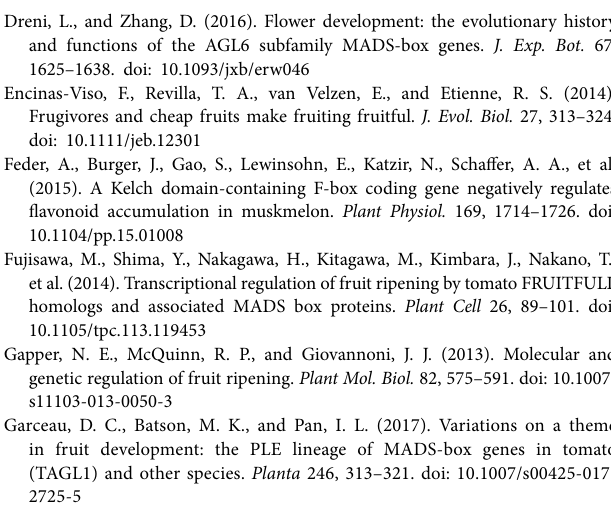
Supplementary Figure S1 | Transverse sections of the groove and non-groove F 2